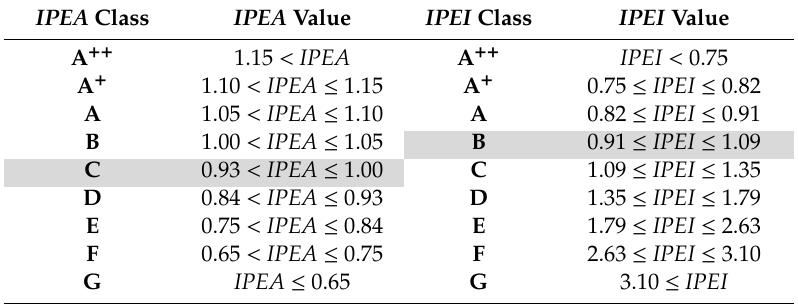
Table A1. (left) Energy classes for luminaires in function of the IPEA indicator (in grey the minimum class required in Emilia Romagna Region). (right) Energy classes for lighting systems in function of the IPEI indicator (in grey the minimum class required in Emilia Romagna Region). IPEA Class IPEA